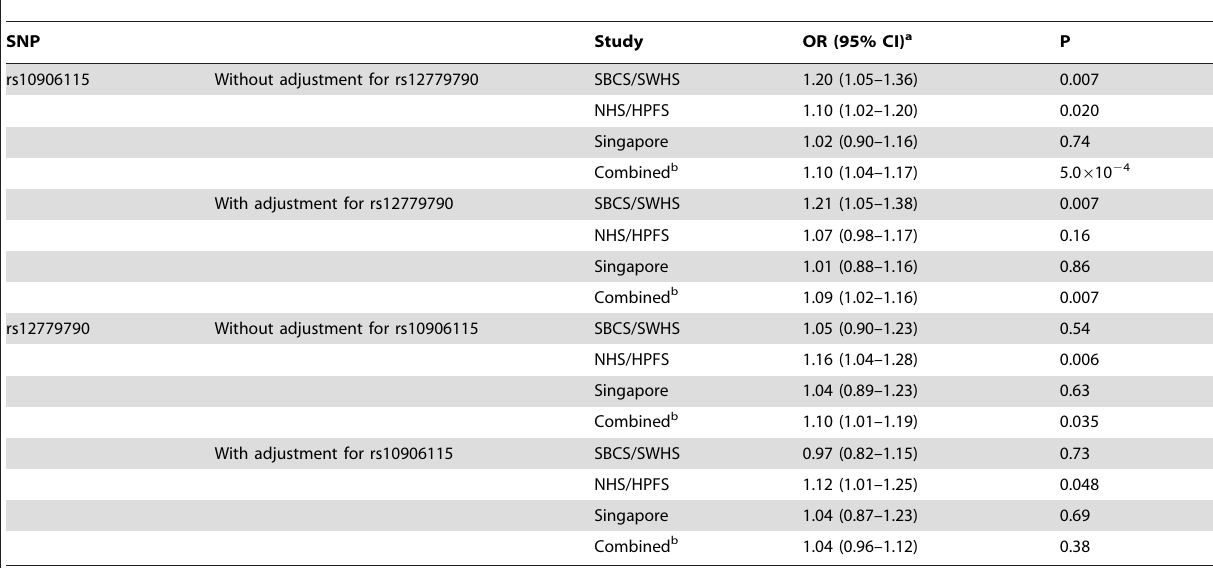
Table 4. Association of SNPs rs10906115 and rs12779790 with type 2